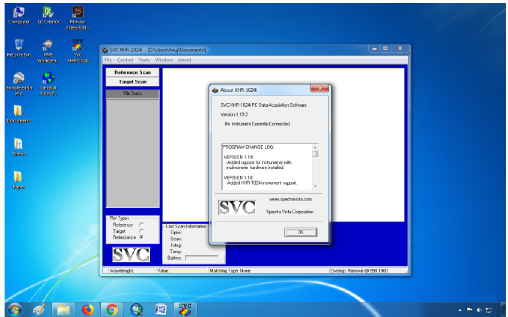
Figure 3. (a)Specifications of SVC PC Data Acquisition Software